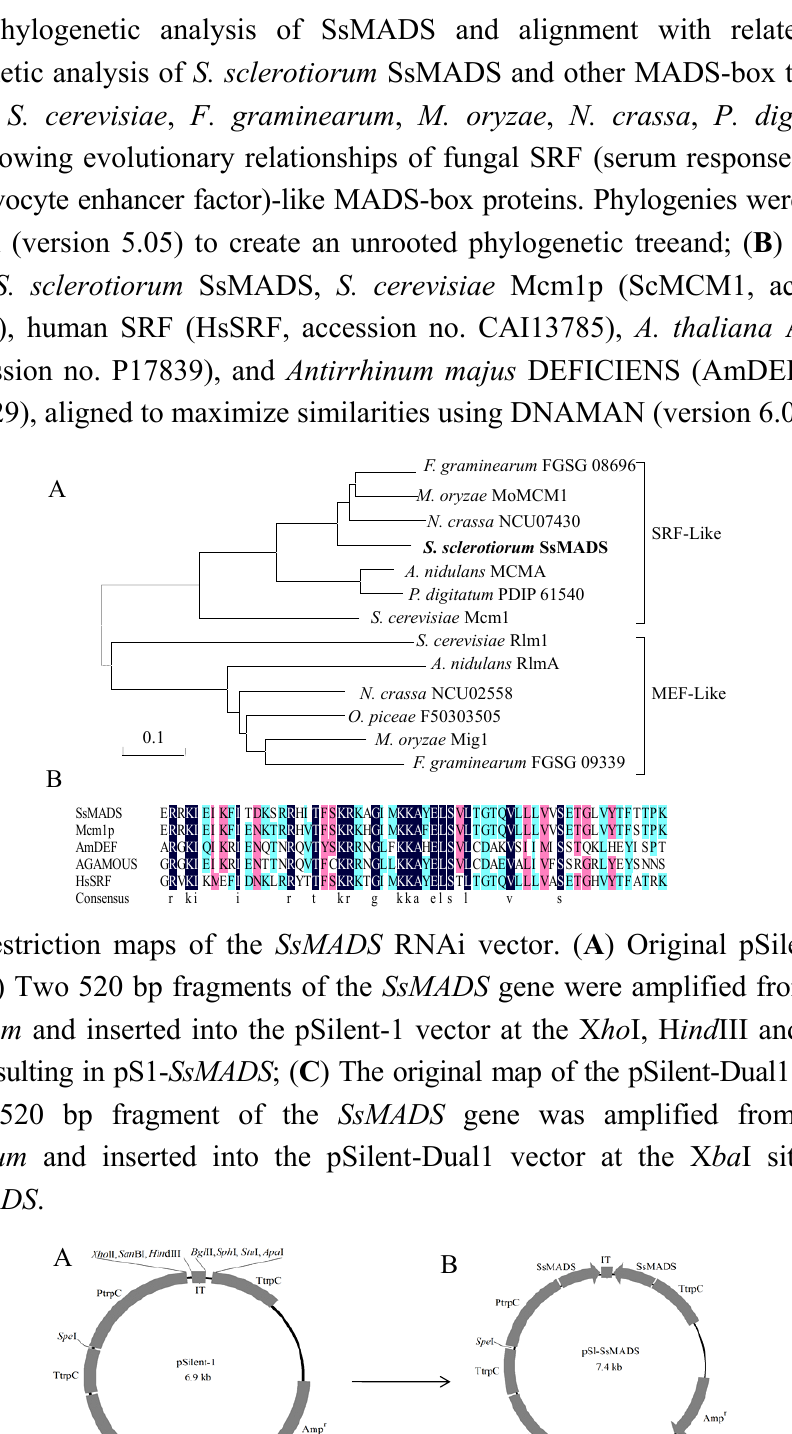
Figure 1. Phylogenetic analysis of SsMADS and alignment with related proteins.